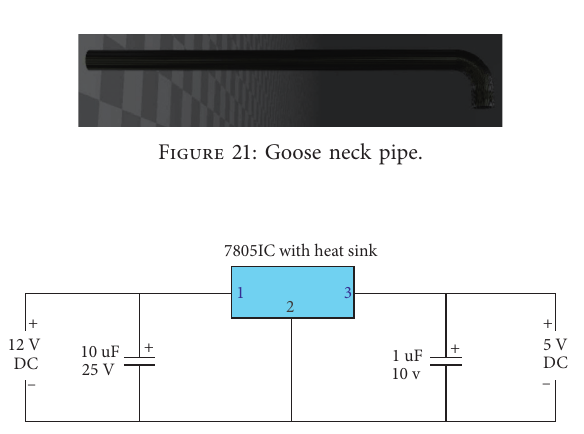
Figure 22: 12V to 5V converter.